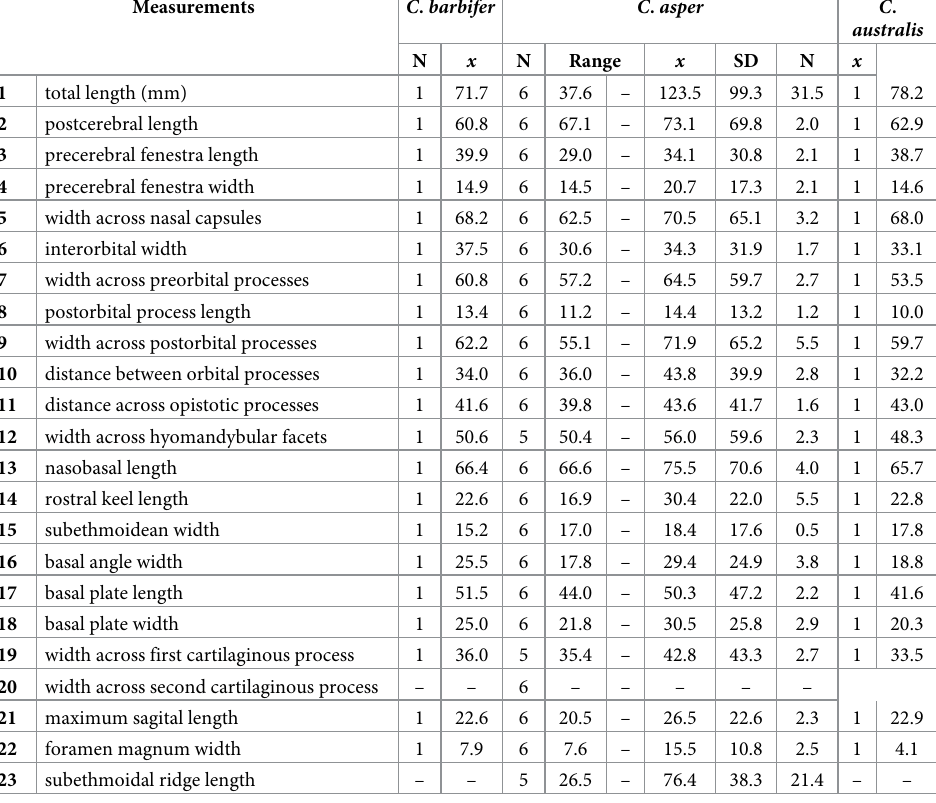
Table 4. Cranial measurements of C . barbifer , C . asper and C . australis expressed as percentage of total length of the neurocranium (%